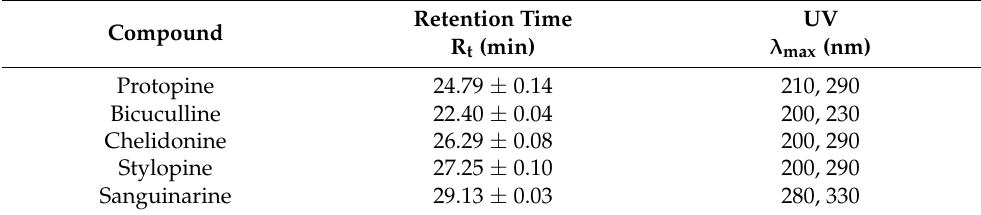
Table 2. Alkaloids identified in the tested F. schleicheri